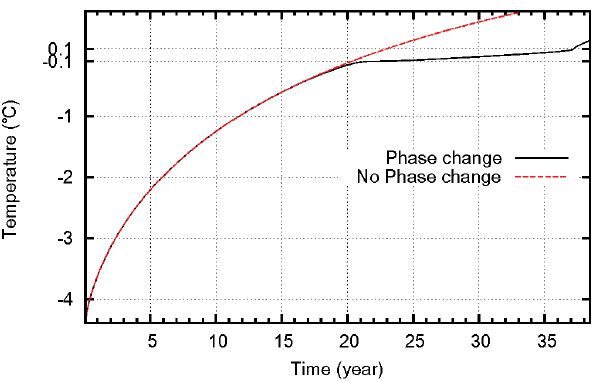
Figure 6. Internal temperature evolution diagram when ice is melt-